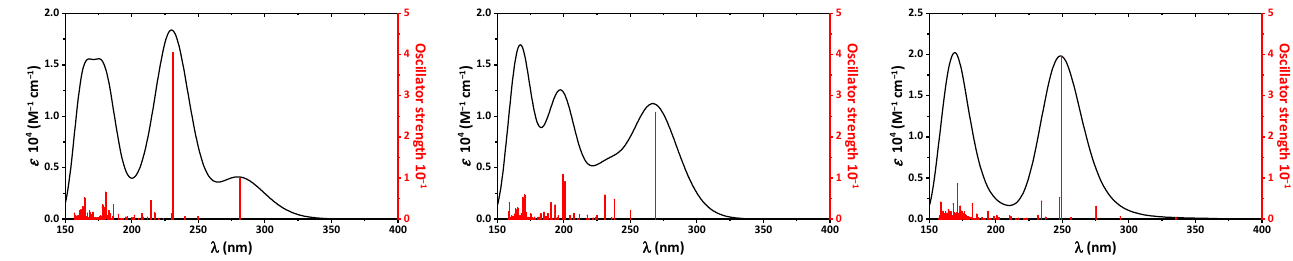
Figure 6. The calculated UV-vis spectra of the keto-oxime (left), keto-hydroxylamine (middle), and hydroxyl-oxime (right) tautomers of molnupiravir, obtained by using the TD-DFT/B3LYP/6- 311++G(d,p) method.